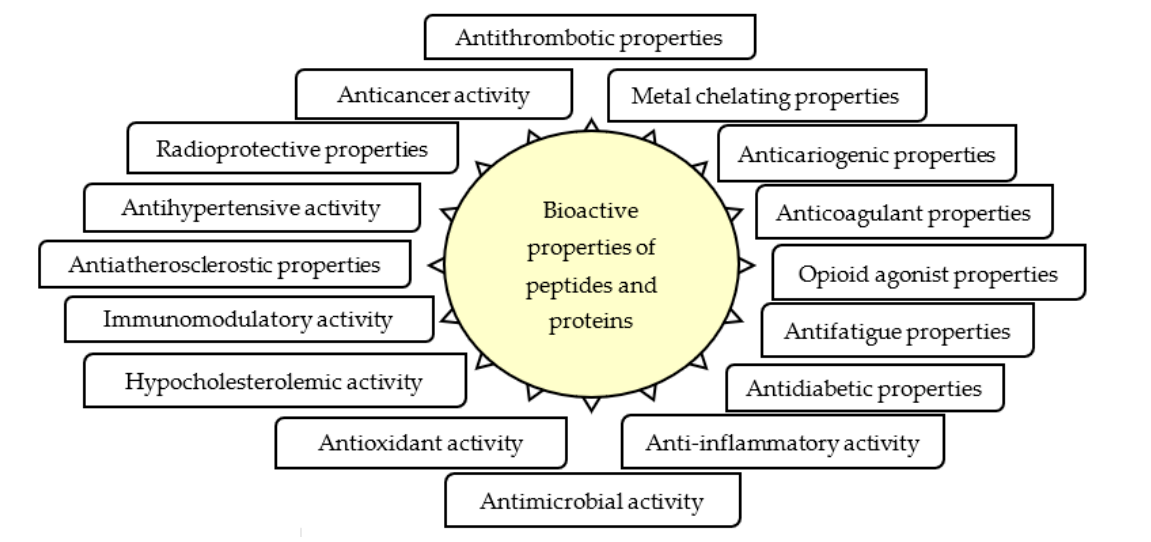
Figure 1. Array of bioactive properties of peptides and proteins [3,9–16].